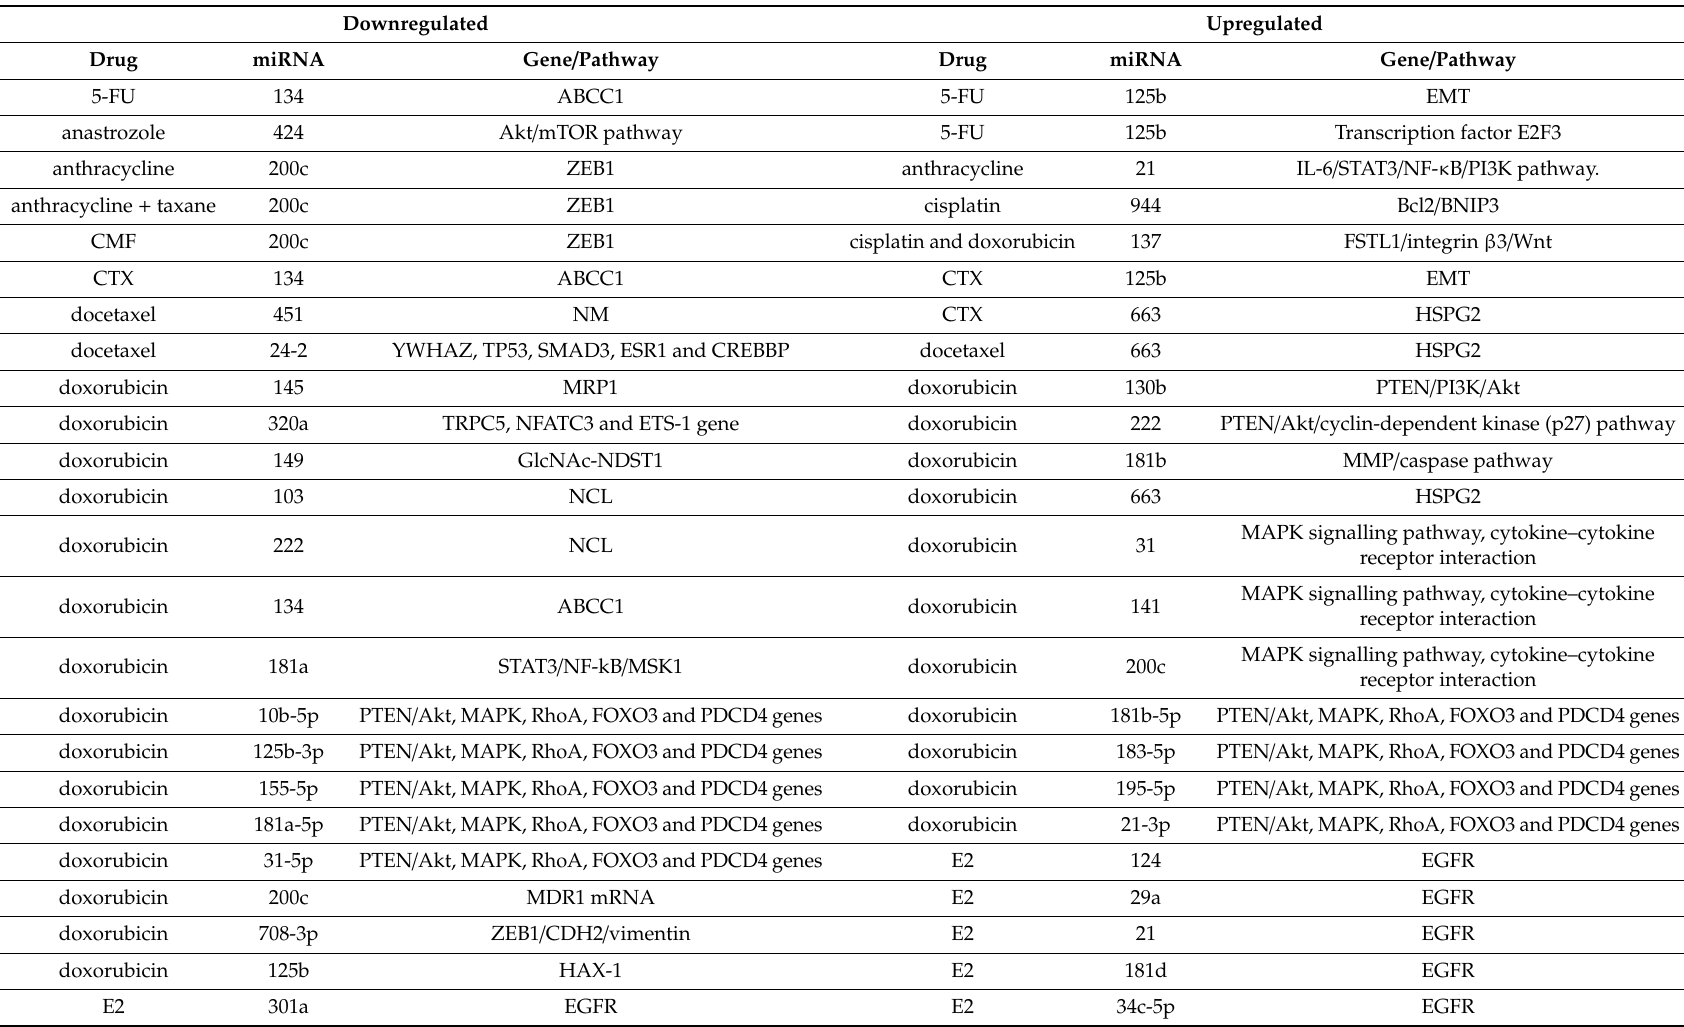
Table 2. Pathways involved in